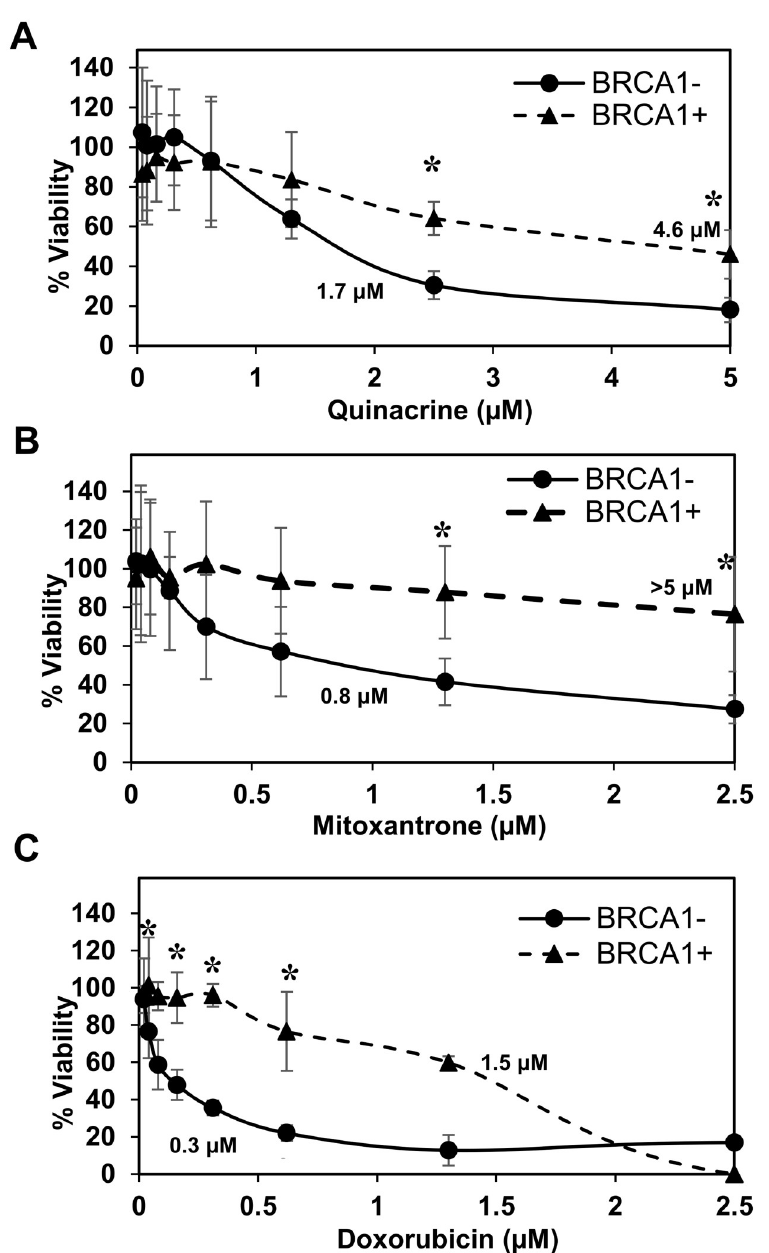
Fig 2. BRCA1-deficient HCC1937 breast cancer cell line survival assay. BRCA1-deficient HCC1937 cells corrected with wild-type BRCA1 gene (BRCA1+; closed triangle), and with an empty vector (BRCA1-; closed circle) were examined. For each experiment (Figs 2–4), cell lines were treated with nine concentrations of (A) quinacrine, (B) mitoxantrone, and (C) doxorubicin in 96-well culture plates at 5x10 3 cell/well density. Each treatment point was made in sextuplicate. Treated cells were incubated for 72 hours at 37˚C before assessing cell viability using PrestoBlue. Data were normalized to vehicle control. The experiment was repeated three times. Error bars indicate the standard deviation. Significantly different data are indicated with an asterisk. EC 50 values, estimated from the graphs, are given. SYr12 and SYr13 are laboratory-generated PARPi-resistant cell lines derived from BRCA1- mutated UWB1.289. These two cell lines gained the BRCA1-independent, ATR-dependent loading of RAD51 in HR and fork protection and restored PARPi resistance [43]. Mitoxan- trone and doxorubicin showed preferential cytotoxicity to the PARPi-resistant UWB1-SYr12